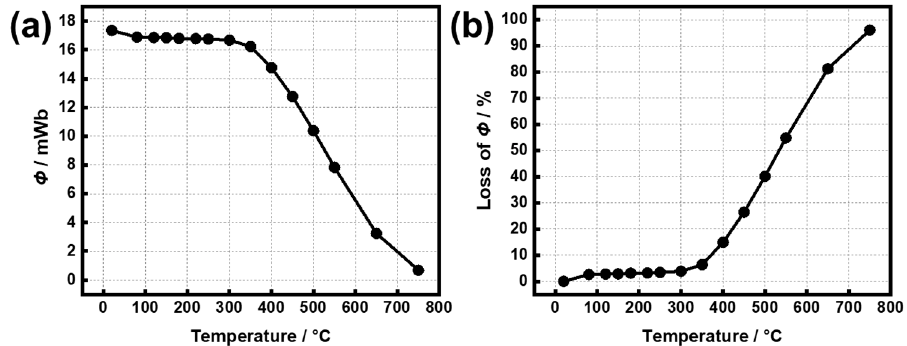
Figure 1. Temperature dependences of ( a ) Φ and ( b ) its losses of the untreated Sm(Co, Fe, Zr, Cu) 7.8 samples from R.T. to 750 °C.